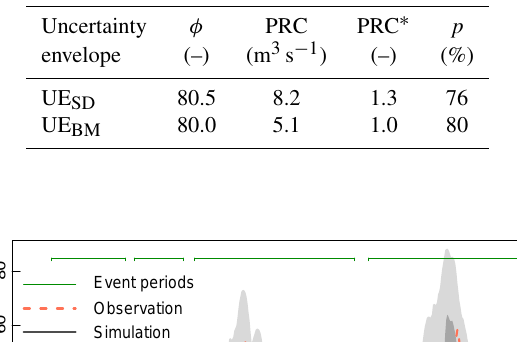
Table 3. Coverage ( φ ), precision (PRC), and relative preci- sion (PRC ∗ ) of uncertainty envelopes. UE SD and UE BM denote Series Distance and benchmark error model, respectively. The last column ( p ) provides the percentage of sampled values of the corre- sponding distribution(s).